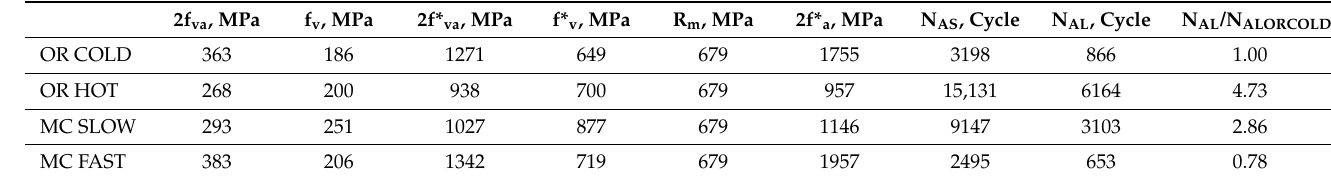
Table 2. Summary of the fatigue life